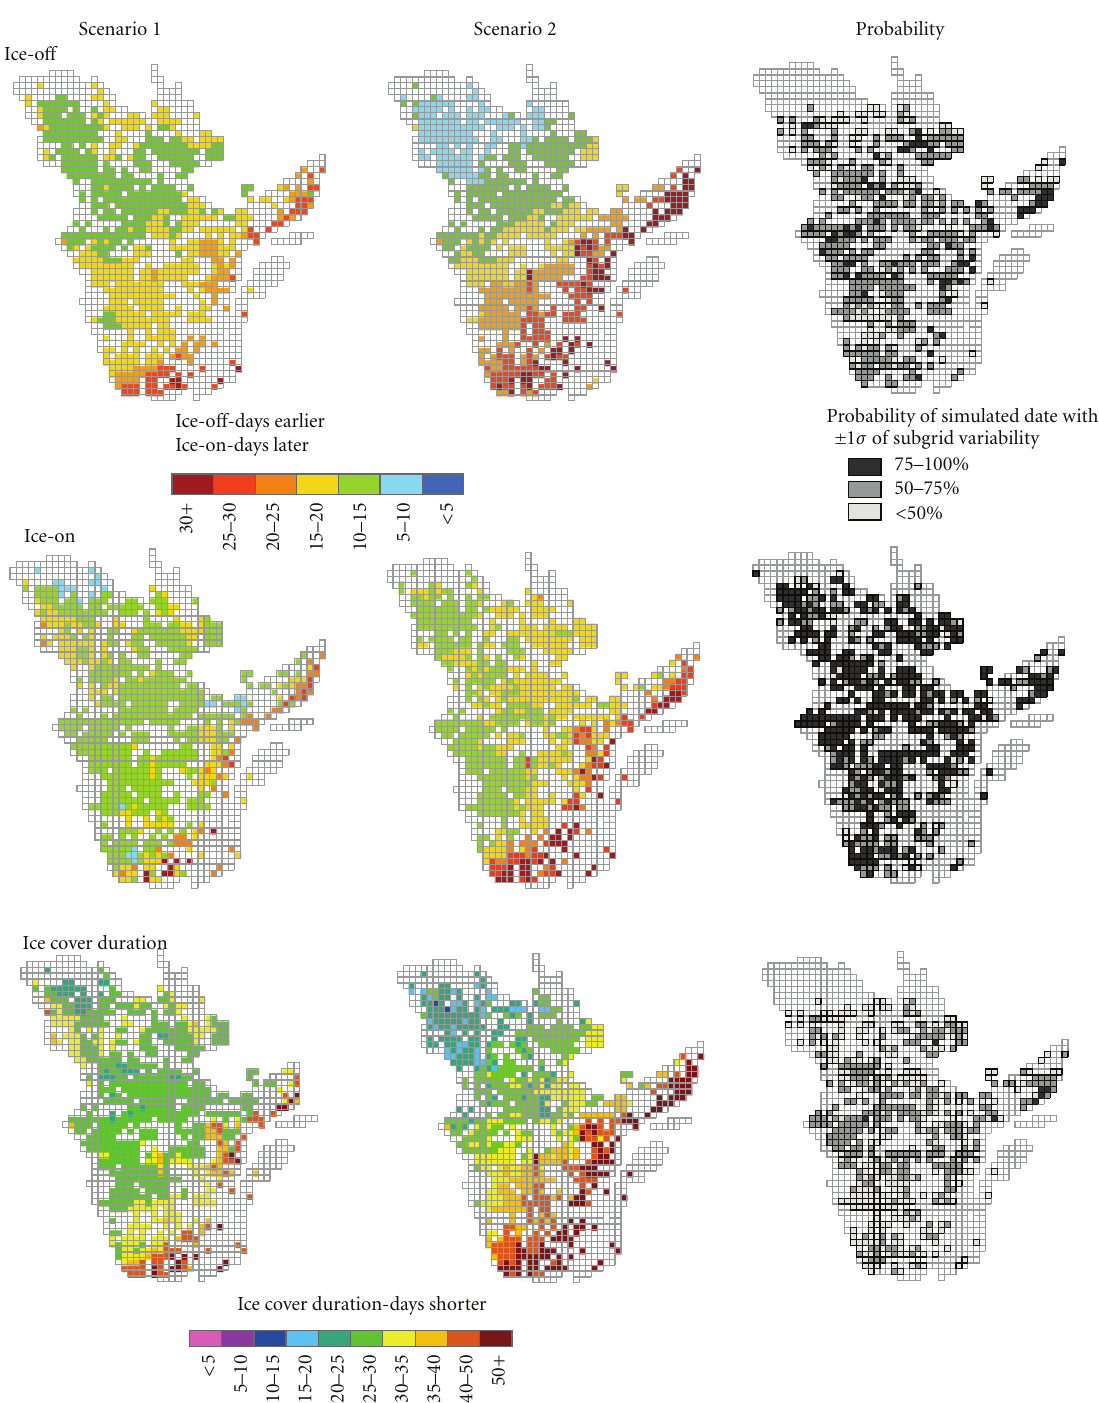
Figure 12: Ice-on, ice-o ff , and ice cover duration (ICD) changes from the 1981–2010 mean to the 2071–2100 mean for both future climate scenarios, with the probability of the model simulating within ± 1 standard deviation of the sub-grid cell variability (from Figure 10) indicated. Grid cells are 32km resolution similar to the previous